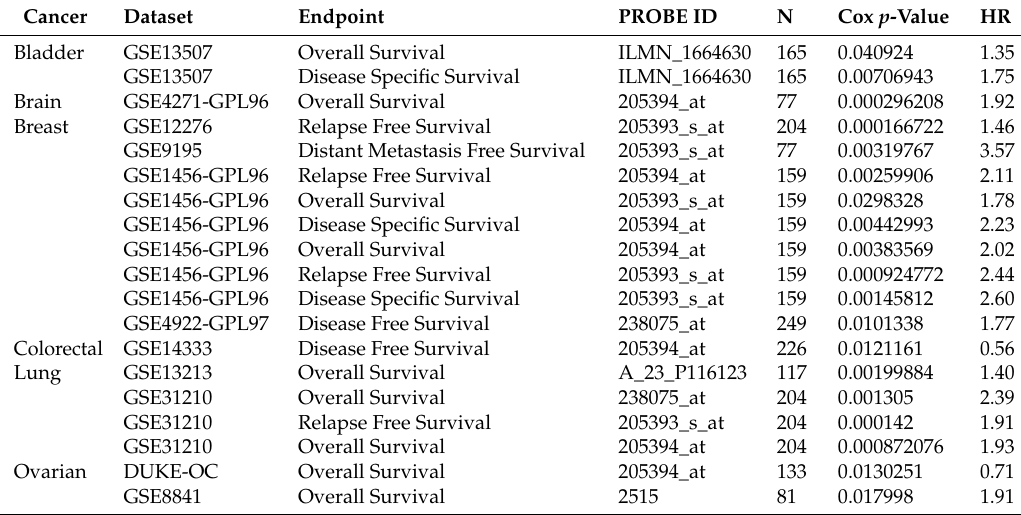
Figure 6. Identification of known and predicted structural proteins essential for CHEK1. The figure consists of 11 nodes and 55 edges, with an average node degree of 6.36 and average local clustering